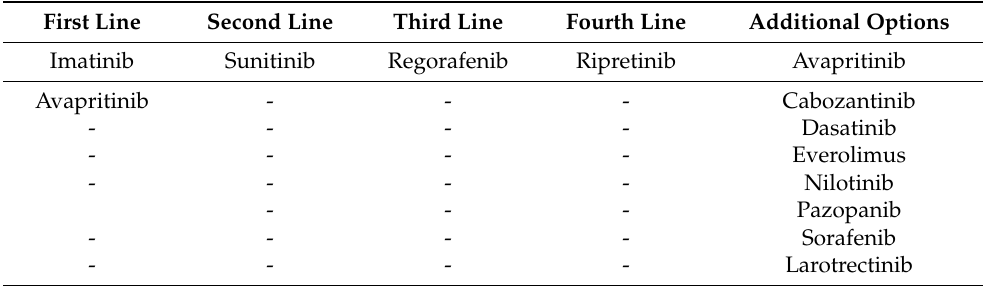
Table 2. Systemic Therapy for Unresectable GISTs (NCCN Guidelines